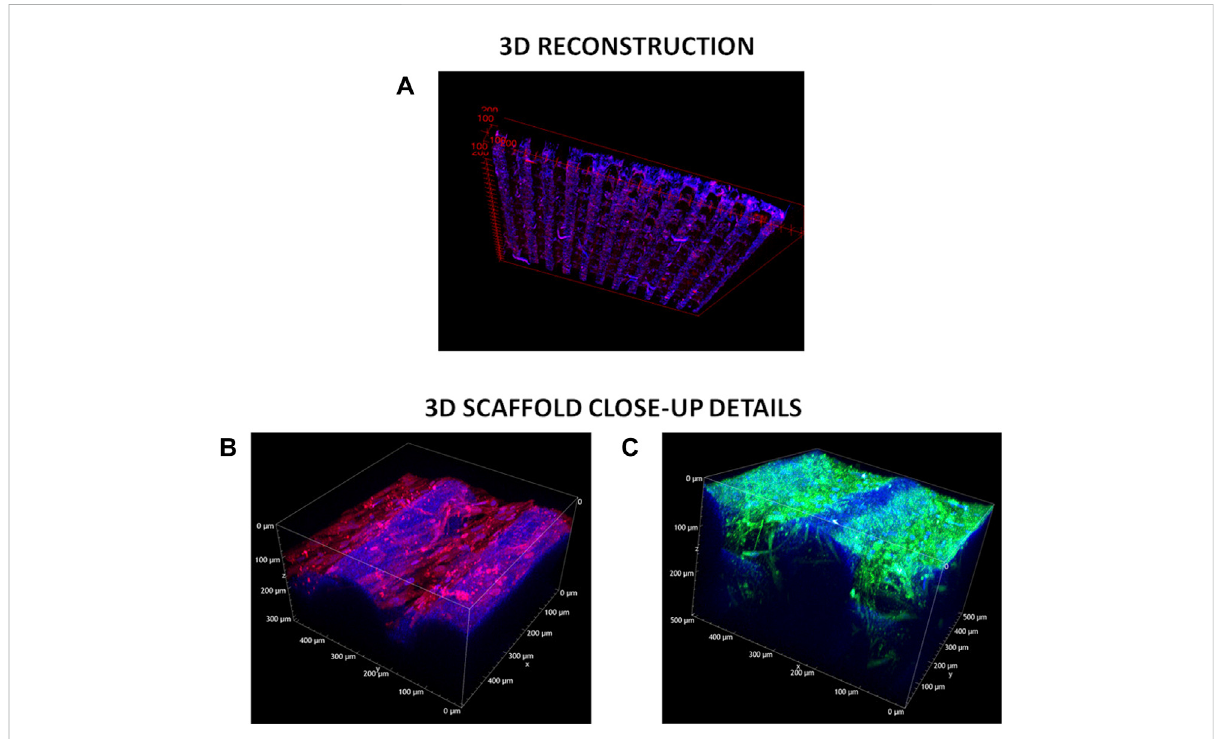
FIGURE 8 TPEF acquisitions. (A) 3D-cellularized scaffolds reconstruction. Blue refers to DAPI staining of cell nuclei, red indicates α -SMA — Alexa Fluor 555immunostaining. (B) z-Stackmeasurementonthe3Dcellularizedscaffoldstainedfor α -SMA.Excitationwavelengthwas950 nm.Signalacquired in the red channel (641 +/ − 37.5 nm) integrates the tail of the two-photon excited fl uorescence response of Alexa Fluor 555. (C) z-Stack measurement on the 3D decellularized scaffolds stained for collagen I and IV. Excitation wavelength was 950 nm. Signal acquired in the green channel (550 +/ − 44 nm) integrates the two-photon excited fl uorescence response of both Alexa Fluor 488 and Alexa Fluor